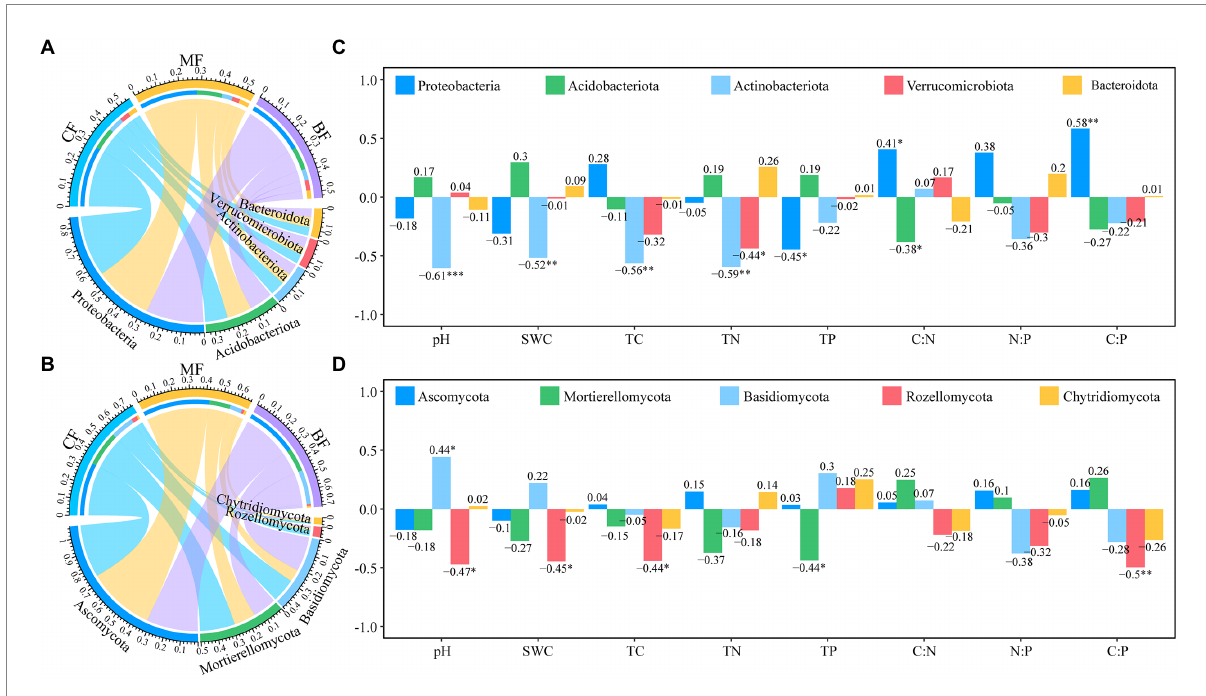
FIGURE 5 Microbial composition of bacteria (A) , and fungi (C) , at the phylum level, and the correlation between soil physicochemical properties and top 5 phylum in the bacterial (B) , and fungal (D) , communities under forest stand